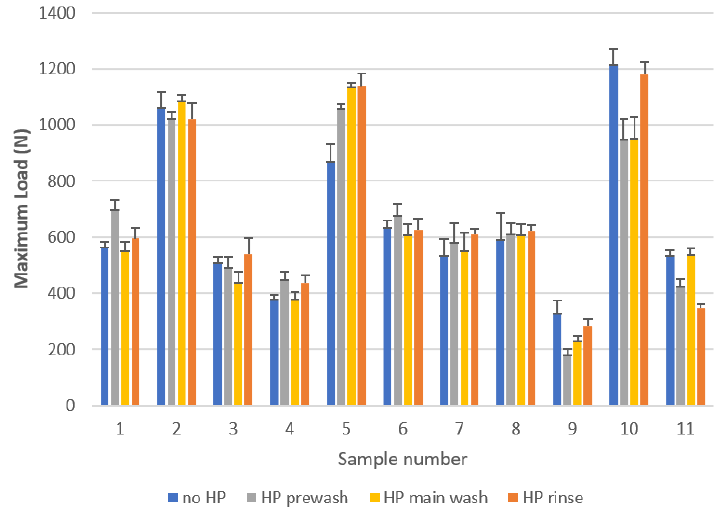
Figure 7. Tensile strength of textile samples after five consecutive washings without and with the addition of 3% HP in the prewash, main wash and rinse cycles at pH 7.